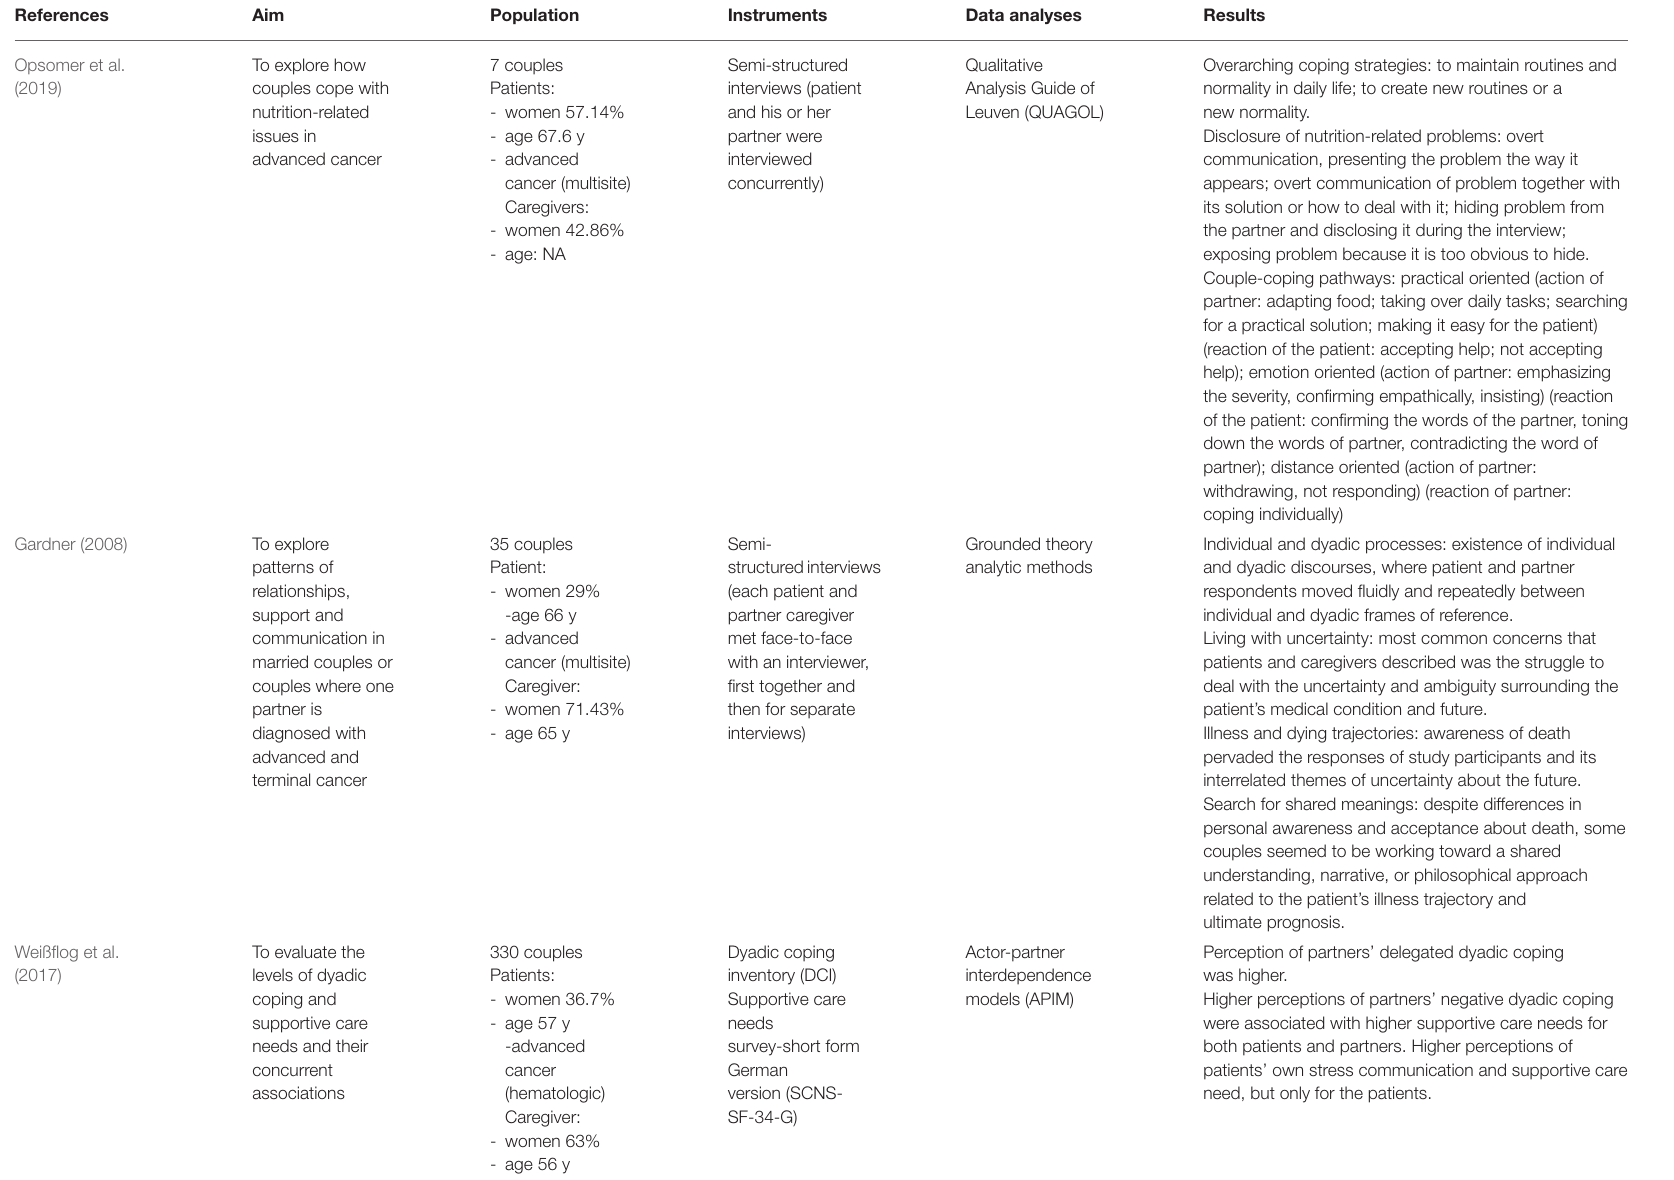
TABLE 1 | Descriptive table of experience of patient-life partner dyad faced with advanced